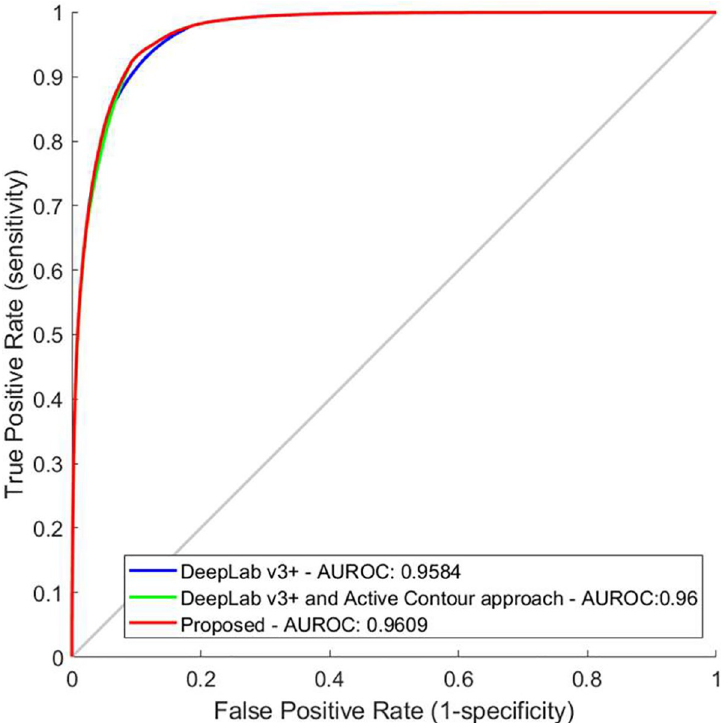
Fig 3. Ablation analysis and performance on tissue slide-based analysis of the a) DeepLab v3+ model, b) DeepLab v3 + and active contour approach and c) proposed methodology. AUROC, area under the receiver operating characteristic curve as shown in the image; FPR, false positive rate; TPR, true positive rate.